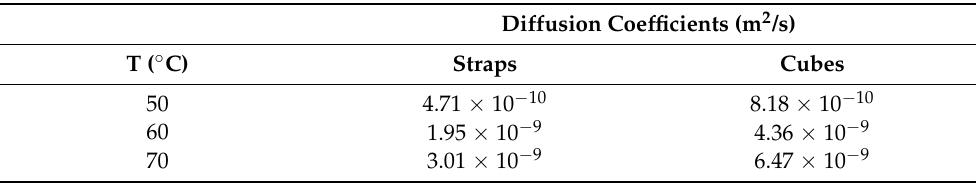
Table 7. Diffusion coefficients found for the drying of prickly-pear cladodes cut into different geometries and exposed to different